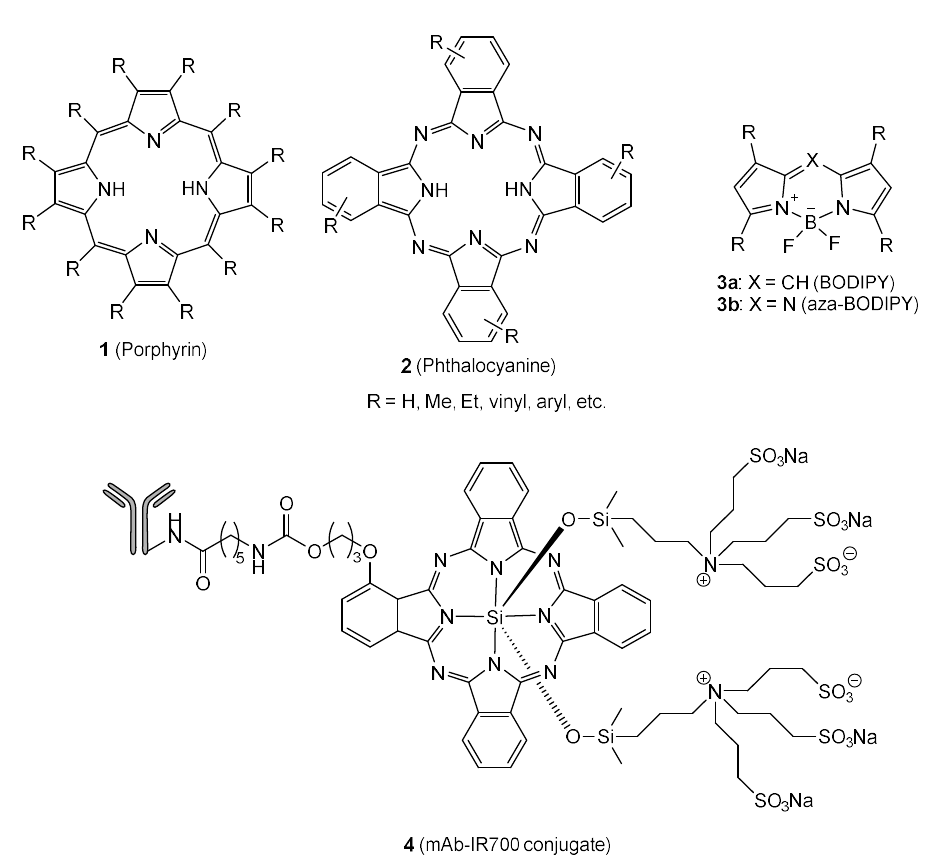
Scheme 1. The structures of representative photosensitizers and antibody-silicon-phthalocyanine conjugates based on porphyrin, phthalocyanine, and BODIPY (4,4-difluoro-4-bora-3a,4a-diaza-s-in-